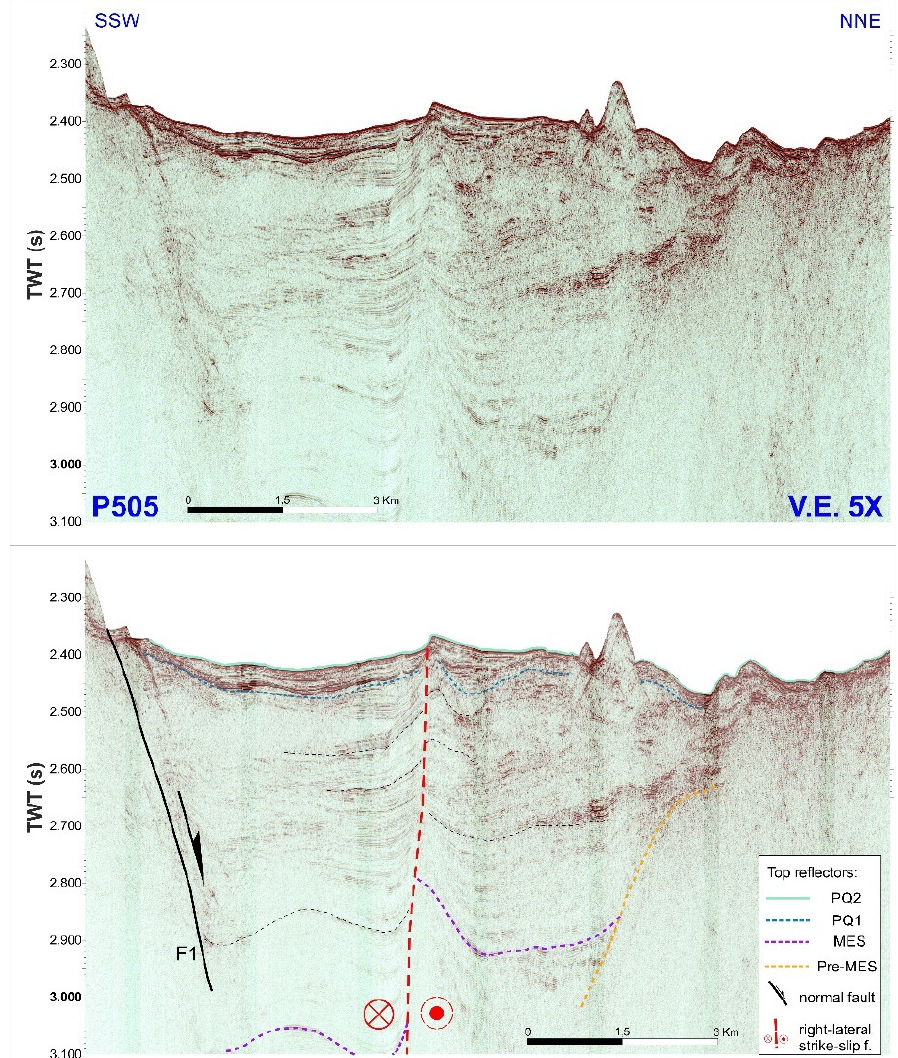
Figure 7. The p505 seismic profile and its interpretation below (see location in Figure 5). Another transtensional feature, interpreted as a pull-apart basin related to dextral strike-slip kinematics by Gutscher et al. [10], is clearly detectable by bathymetric expression to the south-east (Figure 9E). In our opinion, such a structure is related to a releasing bend (sensu Woodcock and Fischer [84]) (Figure